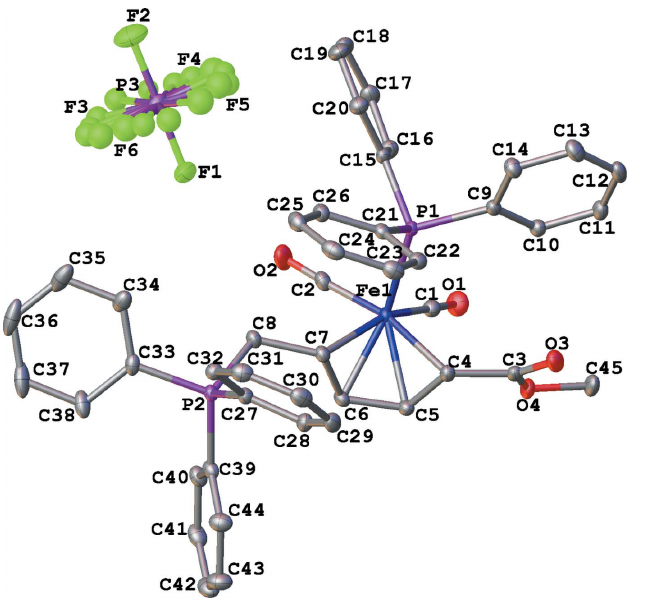
Figure 1 A view of title compound showing 50% displacement ellipsoids and H atoms omitted for